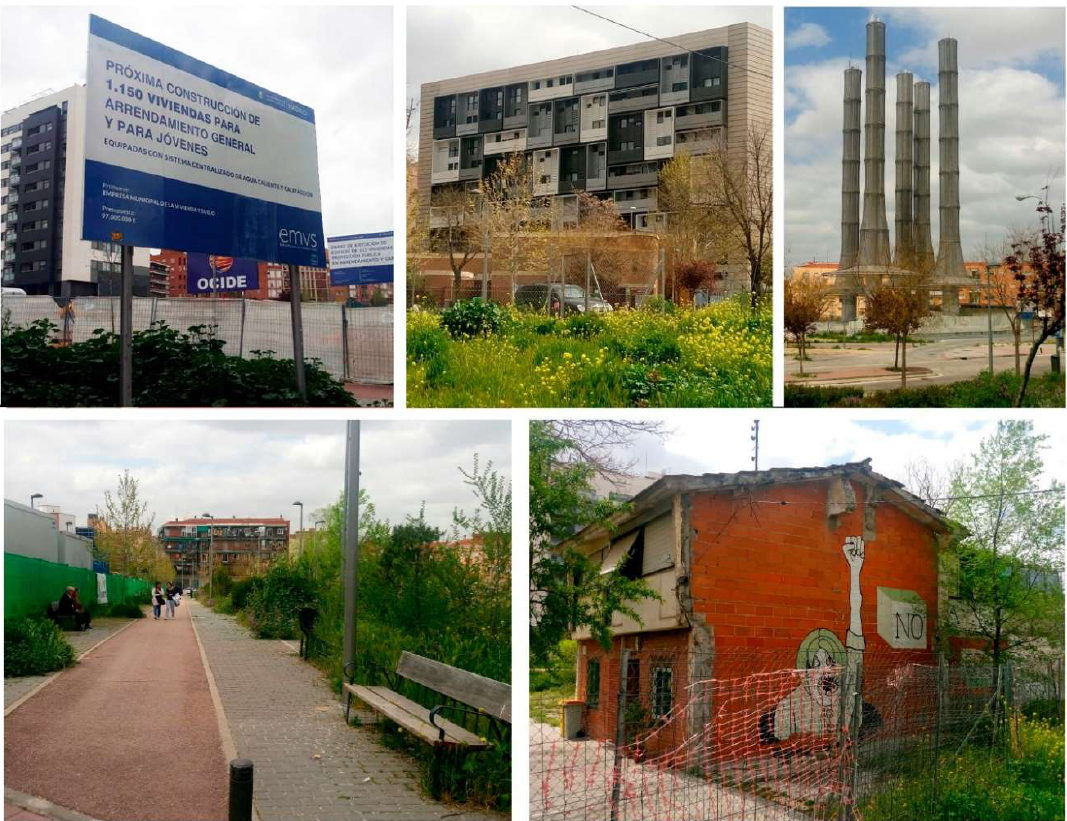
Figure 7. The situation of the eco-neighborhood in April 2008. Publicity for the construction of 1150 homes; the award-winning building found in Peña Gudina Plaza; the thermoelectric plant chimneys; abandoned public areas; and the last single-family home to have resisted demolition. Source: The authors.